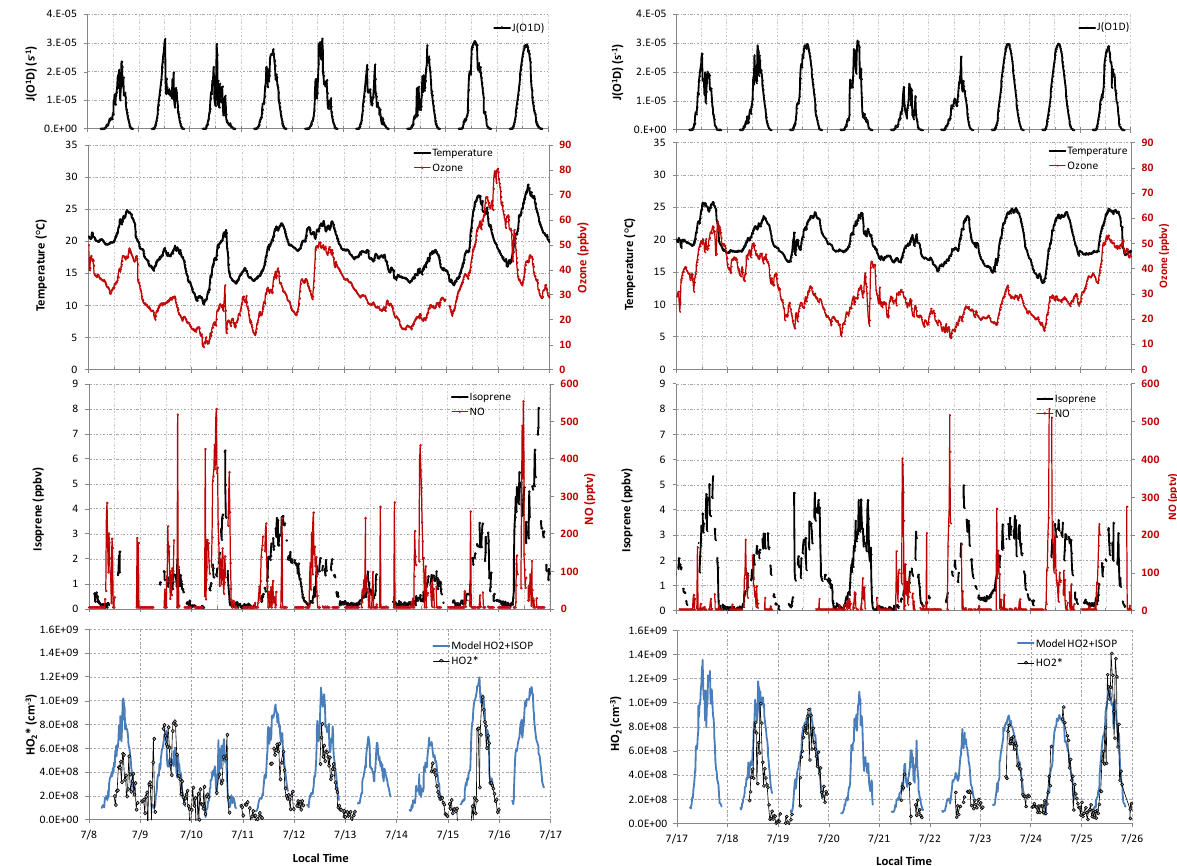
Figure 1: PROPHET 2008 data showing key model constraints and modeled and measured HO 2 * concentrations. Meas- Fig. 1. PROPHET 2008 data showing key model constraints and modeled and measured HO ∗ ured HO 2 * precision (not shown) is approximately 1.5 ×10 7 cm -3 . shown) is approximately 1.5 × 10 7 cm − 3